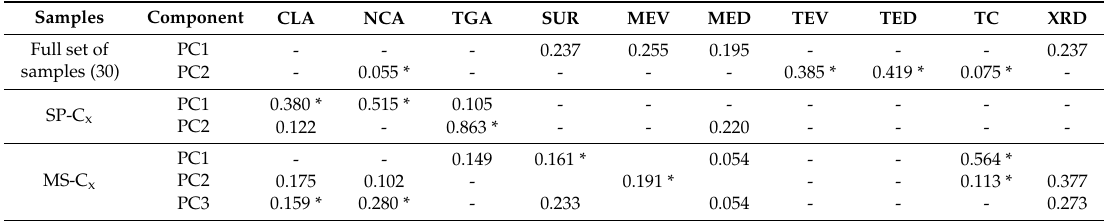
Table 3. Squared values of the loadings of the first Principal